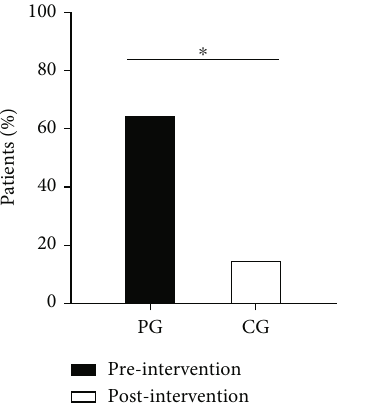
Table 2: Modi fi ed